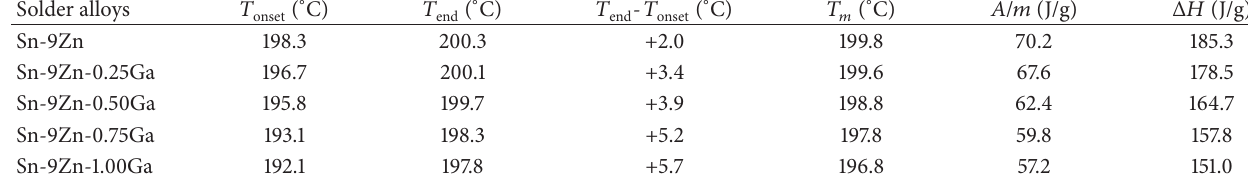
Table 2: The comparison of solidus temperature ( 𝑇 𝐴 / 𝑚 , and Δ𝐻 among various solder alloys.